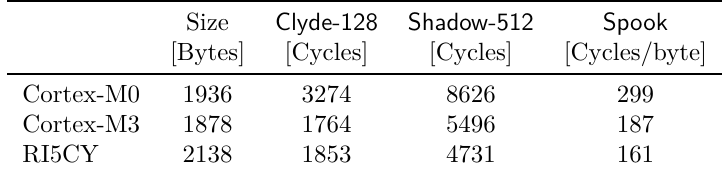
Table 7: Size-optimized performances on embedded platforms (-Os).